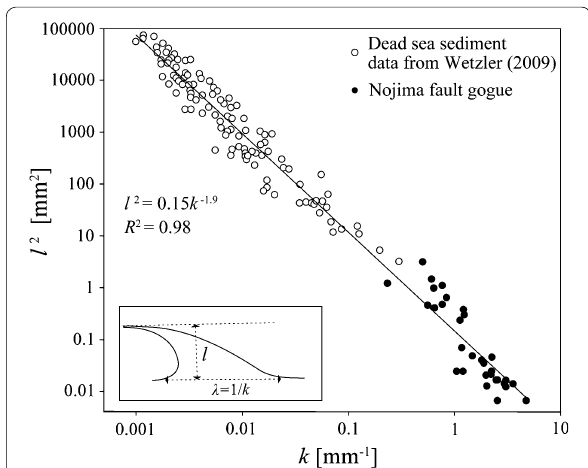
Fig. 3 Spectral distribution of deformation formed in Dead Sea sedi- ments ( open circles Wetzler 2009) and the billow-like wavy folds in the Nojima fault gouge ( solid circles ), where l is width and k is the inverse of the wavelength (1/ λ ) of the billow-like wavy folds. The black line is the mean power fit to the overall